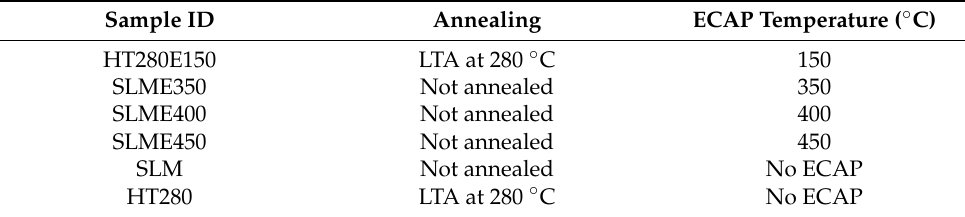
Table 1. Prepared samples used for the study.